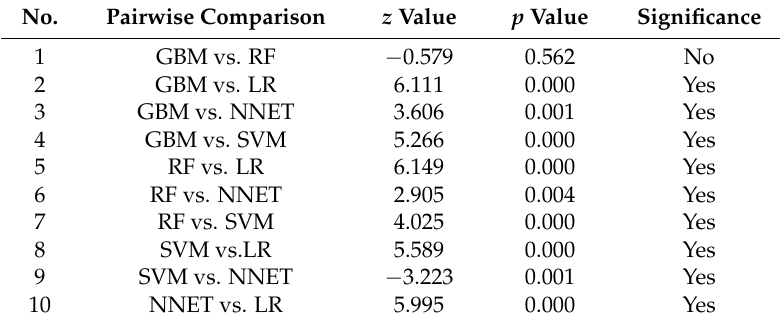
Table 9. The pairwise comparison of the five landslide susceptibility models using the Wilcoxon signed-rank test.